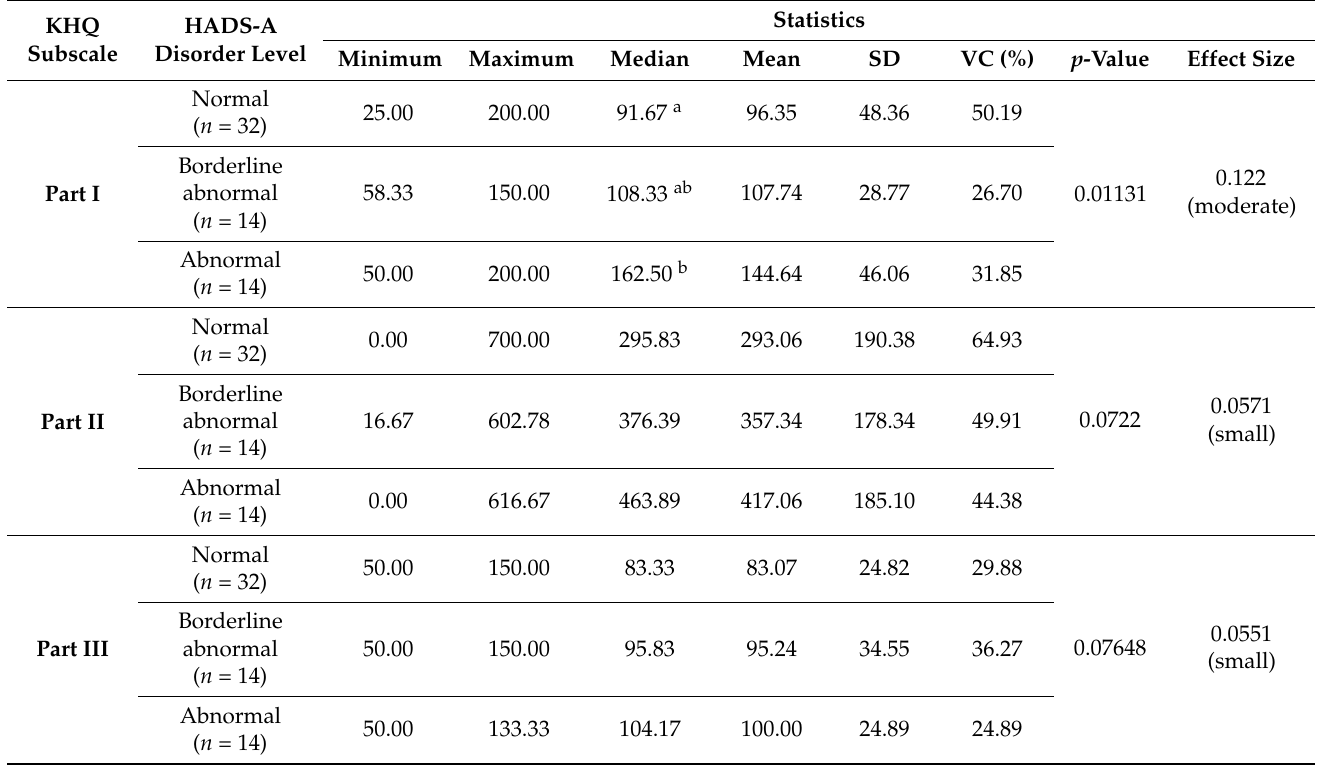
Table 5. KHQ—PART I, II, III sub-scale scores for women before the surgery, with different disorder stages defined based on the HADS-A subscale.